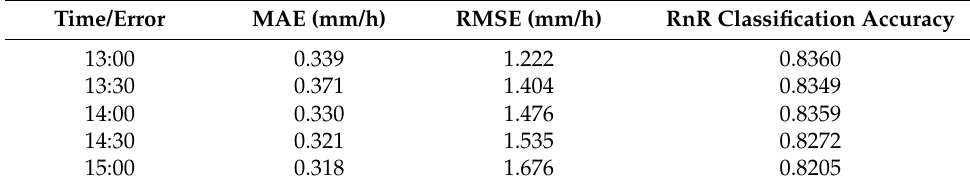
Table 3. The evaluation assessment